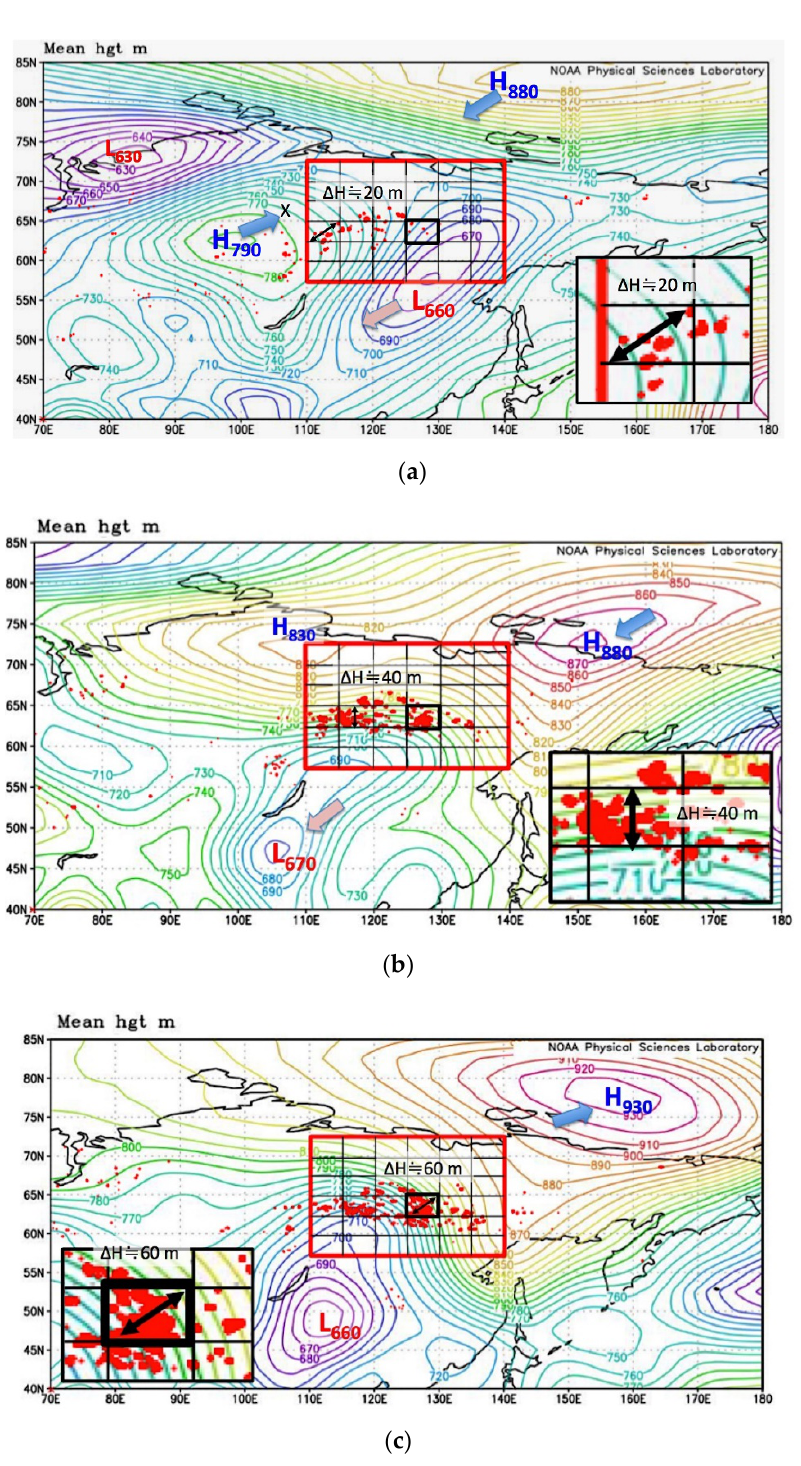
Figure 7. ( a ) Weather map on 24 July. Inserted figure shows the largest HS block and is used to show height gradient ( Δ H). See captions for Figure 4, ( b ) Weather map on 2 August. Inserted figure shows the second HFA and is used to show height gradient ( Δ H). See captions for Figure 4, ( c ) Weather map on 7 August. Inserted figure shows HFA and is used to show height gradient ( Δ H). See captions for Figure 4. High-pressure systems (H 790 , 63 ◦ N, 99 ◦ E) in Figure 7a moved in from the south and developed until 26 July. From 27 July, high-pressure systems from the north moved into northern Sakha and developed. Under developed, high-pressure systems, H 880 (73 ◦ N, 152 ◦ E) and H 830 (72 ◦ N, 110 ◦ E) in Figure 7b, fires (HSs) in the middle latitude of Sakha became